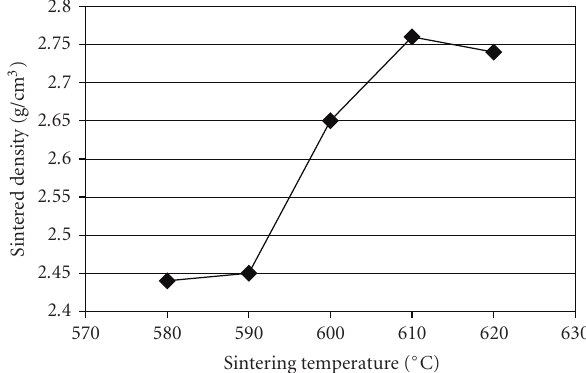
Figure 1: Sintered density as a function of sintering temperature (sintering 30 minutes in N 2